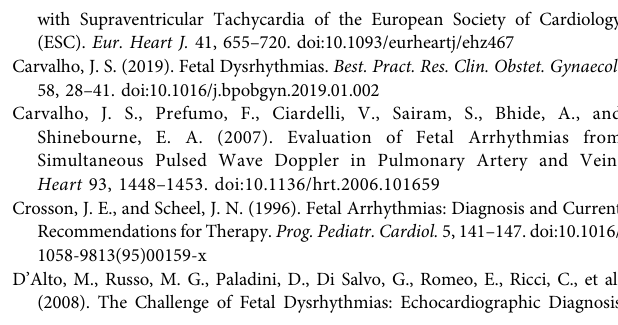
Supplementary Figure S2 | Gelman Runbin plot of SVT group. Supplementary Figure S3 | Gelman Runbin plot of AF group. Supplementary Figure S4 | Gelman Runbin plot of Hydrops group. Supplementary Figure S5 | Gelman Runbin plot of Non-hydrops group. Supplementary Figure S6 | Gelman Runbin plot of Death group. Supplementary Figure S7 | Gelman Runbin plot of Safety Index